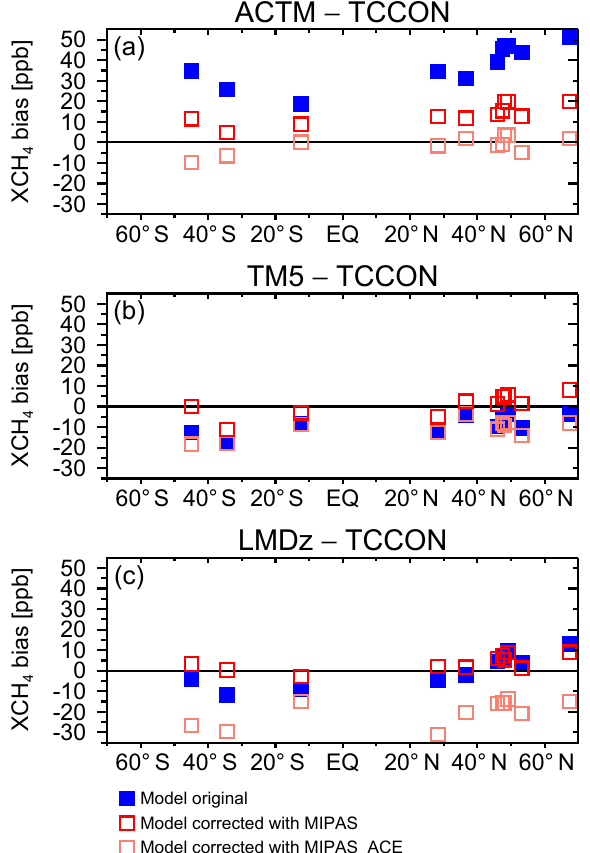
Figure 2. Site-specific model XCH 4 biases with respect to TCCON observations in parts per billion (ppb) for the year 2010. Different colors indicate different stratospheric CH 4 fields used for the calcu- lation of model XCH 4